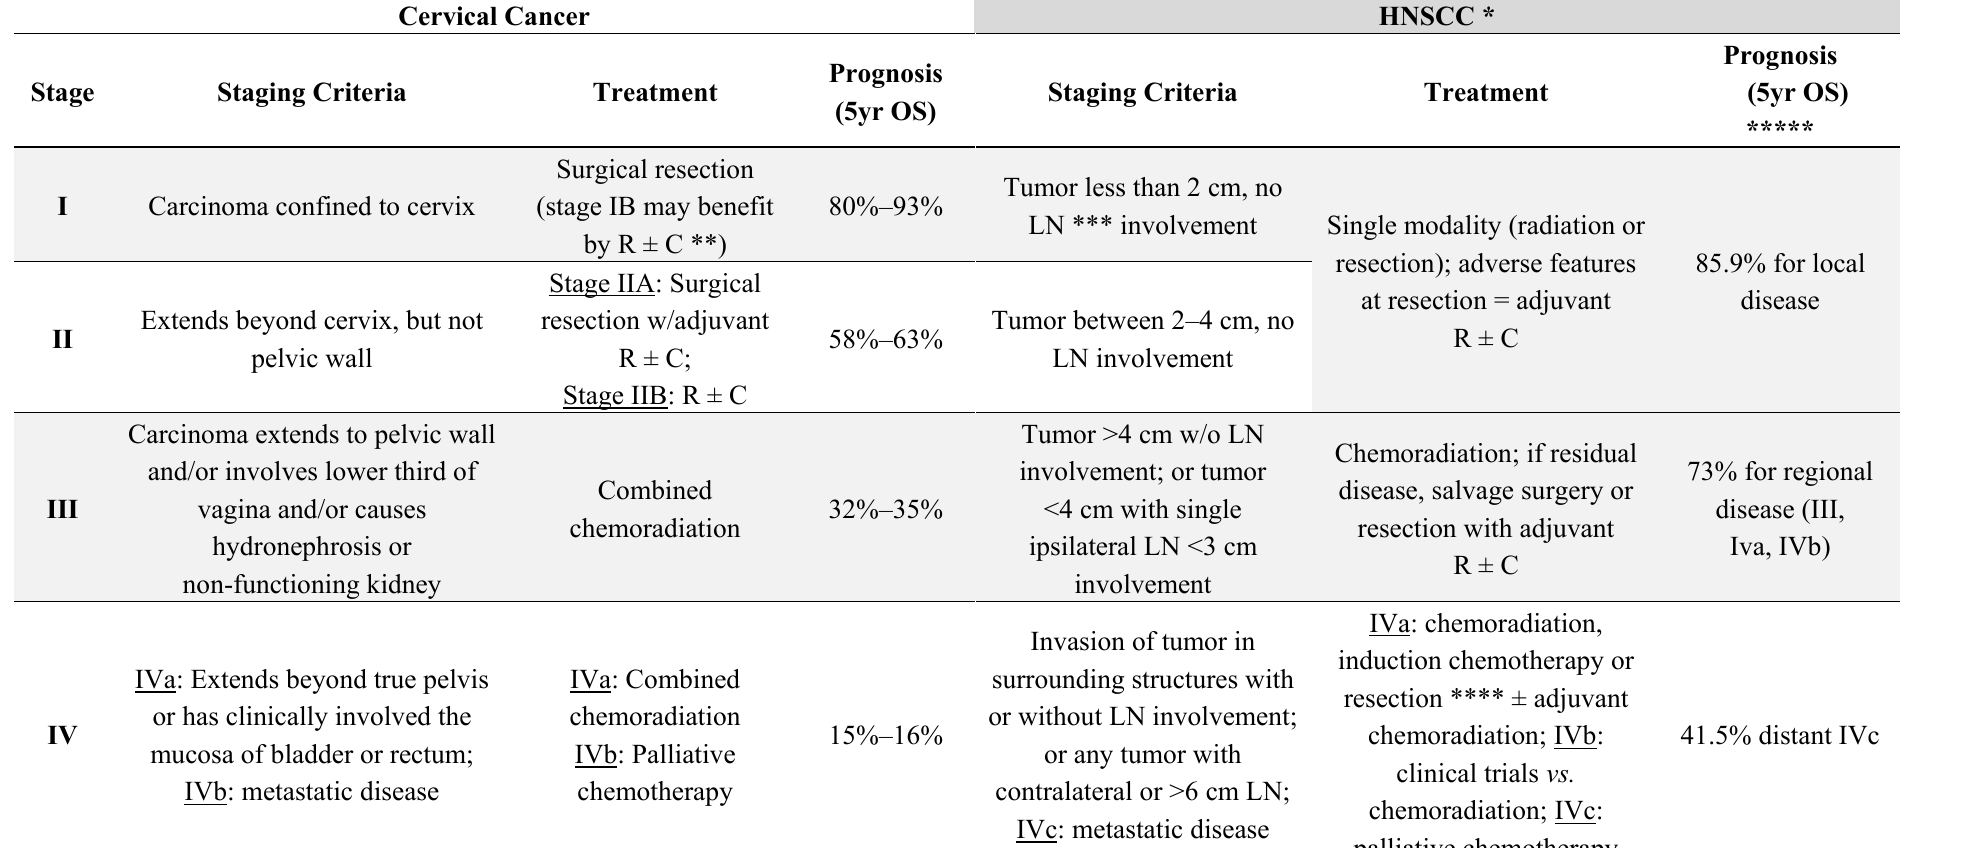
Table 2. Staging Criteria and Prognosis for Squamous Cell